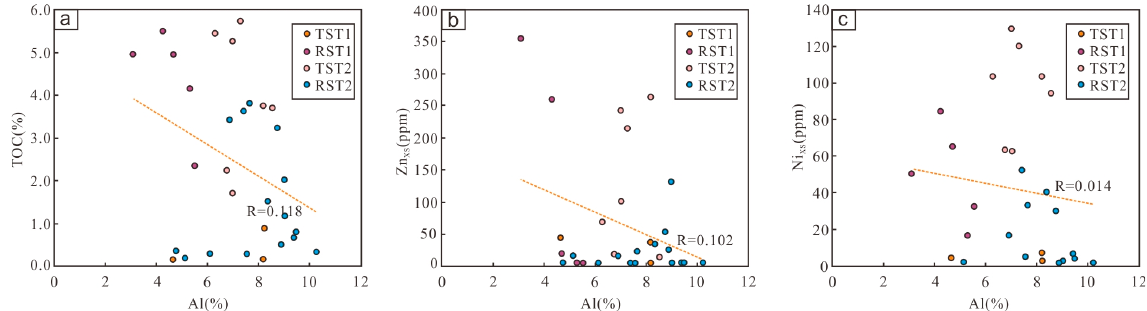
Figure 10. Crossplots of Al vs. ( a ) TOC, ( b ) Zn XS , and ( c ) Ni XS of samples from Well